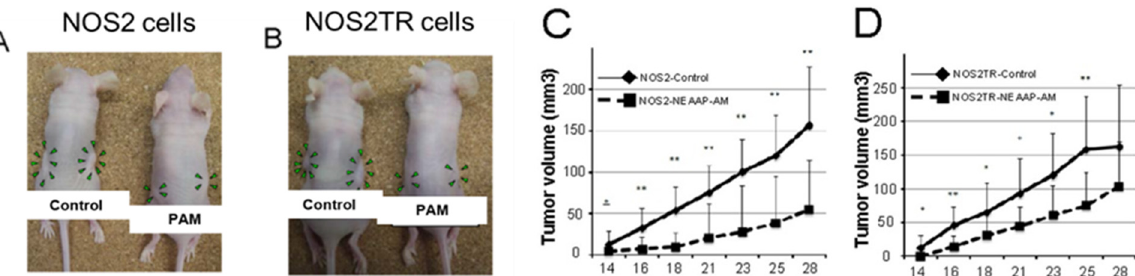
Figure 13. Antitumor effect of PTS (RPMI, “PAM”) in mice with NOS2 and NOS2TR (paclitaxel-resistant) cell lines. ( A , B ): The macroscopic observation of nude mice bearing subcutaneous NOS2 ( A ) and NOS2TR ( B ) tumors on both flanks. Mice were injected with NOS2 and NOS2TR cells and then received medium alone or NEAPP-AM. A total of 0.4 mL of medium or NEAPP-AM was administered locally into both sides of mice three times a week. All mice were sacrificed at 29 days after implantation. Green arrowheads indicate tumor formation. ( C , D ): Time-dependent changes in the tumor volume in xenografted models are shown, medium alone or NEAPP-AM. Each point on the line graph represents the mean tumor volume (mm 3 ) for each group on a particular day after implantation, and the bars represent SD. * p < 0.05, ** p < 0.01 versus control. Reproduced from [39] . Copyright 2013 PLOS.